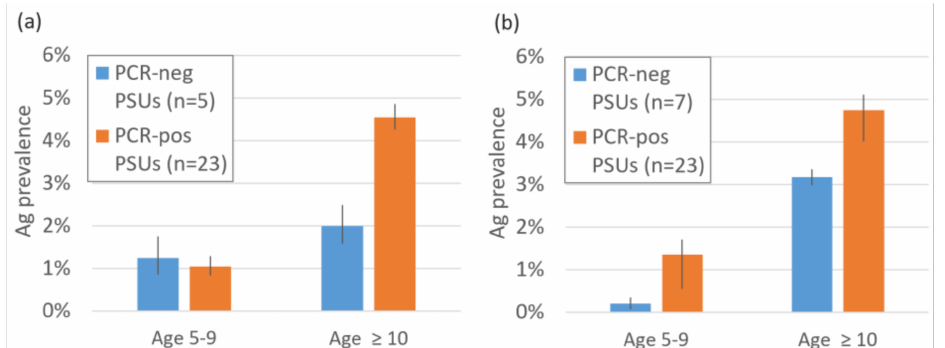
Figure 6. Estimated Ag prevalence in primary sampling units (PSUs) with and without PCR-positive mosquito pools in ( a ) 2018 and ( b ) 2019.